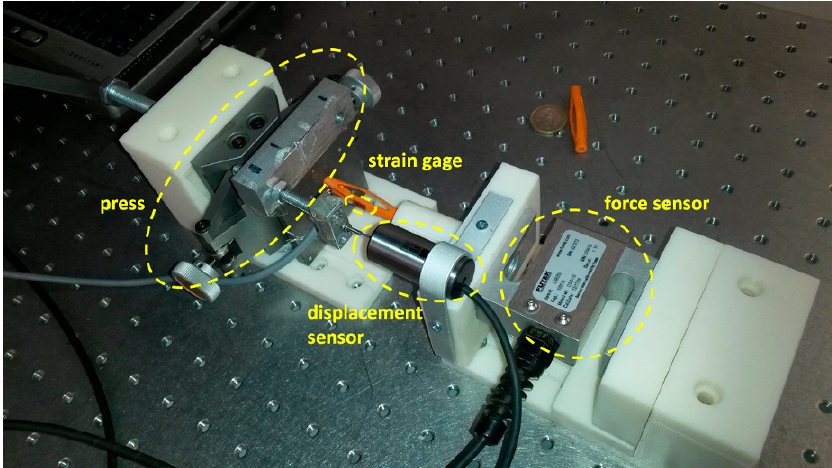
Figure 13. Scheme of the setup used for laboratory validation.